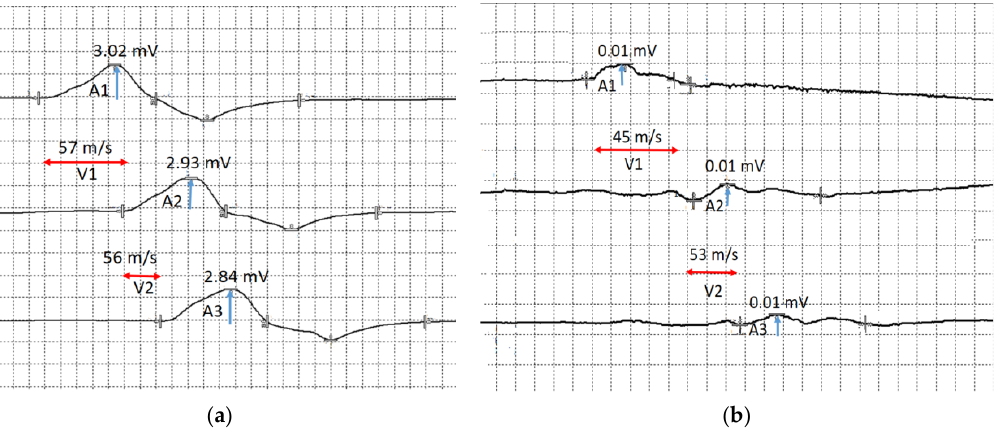
Figure 8. The motor conduction velocity of the ulnar nerves: ( a ) motor conduction velocity of the left ulnar nerve below the elbow (V1) and above the elbow (V2), and the compound muscle action potential in response to stimulation at the wrist (A1), below the elbow (A2) and above the elbow (A3); ( b ) motor conduction velocity of the right ulnar nerve below the elbow (V1) and above the elbow (V2), and the compound muscle action potential in response to stimulation at the wrist (A1), below the elbow (A2) and above the elbow (A3). Blue arrows show compound muscle action potential amplitude and red arrows show conduction velocity.